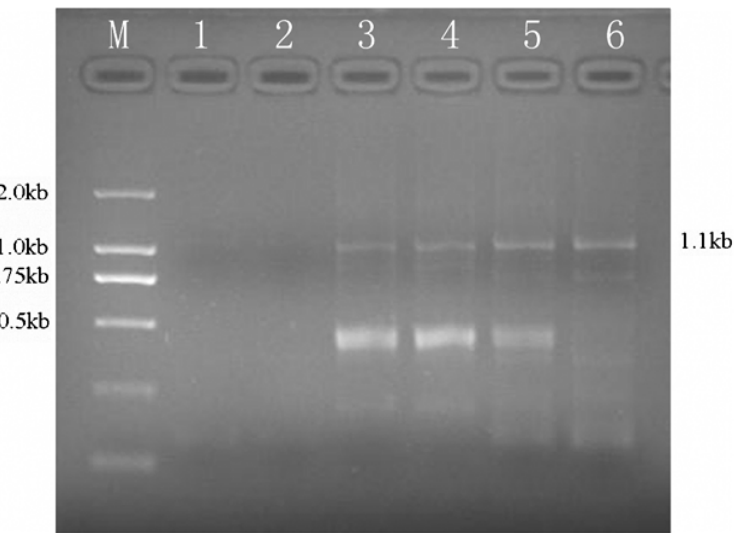
Figure 2. Selection and amplification of anti-SM 2 scFv gene over four rounds of ribosome display. After selection, the selected product was amplified by SP-PCR and the SP-PCR products were analyzed by agarose gel electrophoresis. lane M: DL2000 DNA marker, lane 1: preliminary translation mixture selected on a PBS-coated well, lane 2: translation mixture selected on a OVA-coated well, lane 3: recovered band from the first ribosome display, lane 4: recovered band from the second round, lane 5: recovered band from the third cycle, lane 6: recovered band from the fourth selected library.